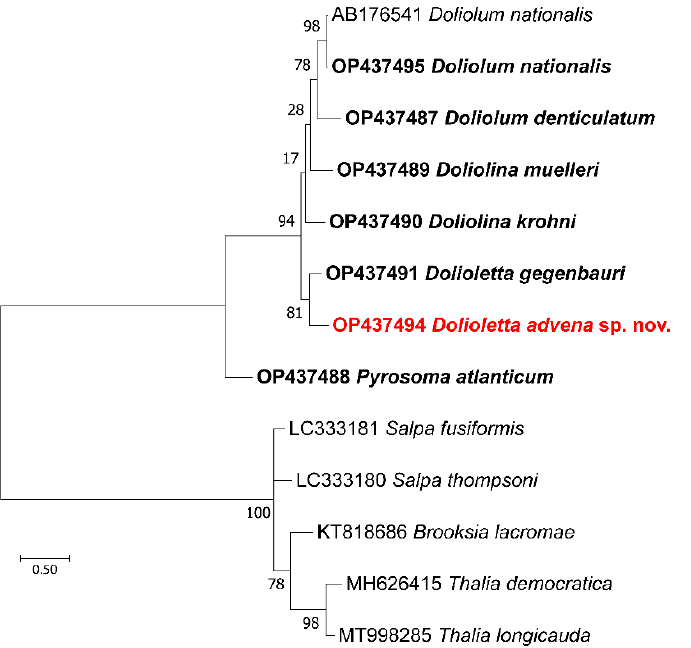
Figure 3. Photographs of Dolioletta advena sp. nov. individuals from which DNA was isolated and COI sequences were obtained. ( a ) gonozooid, isolate dcgen, ( b ) phorozooid, isolate gega, ( c ) phorozooid, isolate gegb.